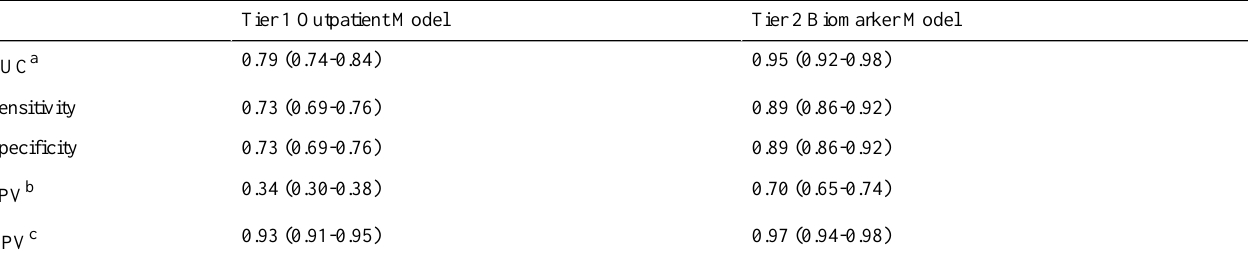
Table 2. Internal validation performance in terms of AUC, sensitivity, specificity, PPV, and NPV (95% CI) from 5-fold cross-validation. The Tier 1 and 2 models were trained and tested using data from Family Health Centers at New York